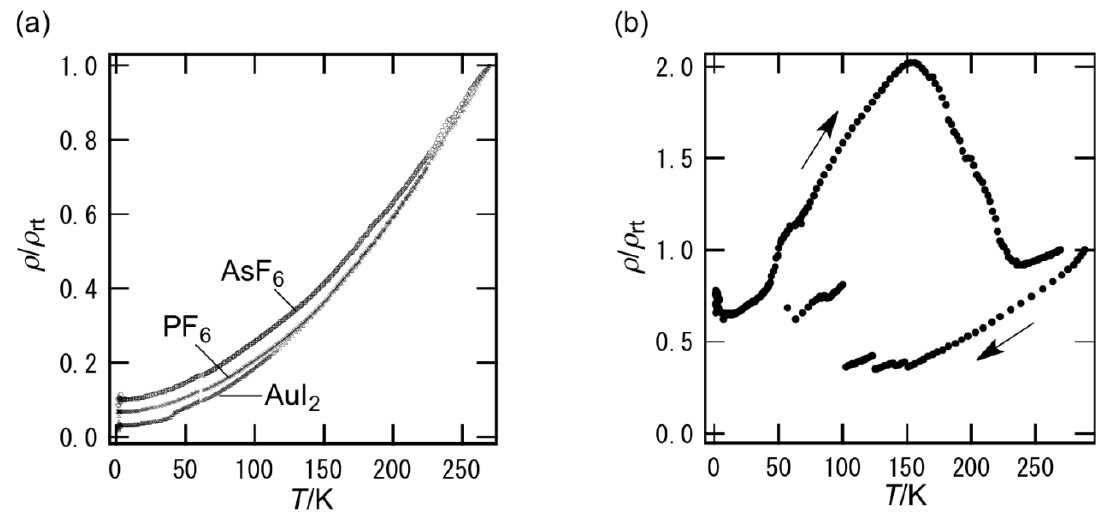
Figure 15. Temperature dependence of the resitivities for the ( a ) AuI ( b ) FeCl salts of DHOT-TTP (Reprinted with permission from reference 40, The 4 Chemical Society of